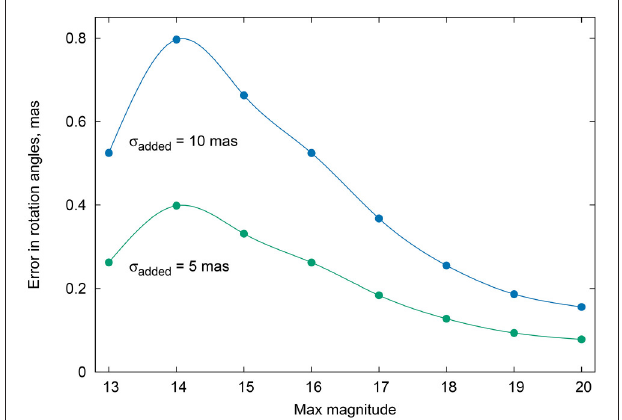
FIGURE 8 | Simulated error in orientation angles depending on the additive error due to radio–optics position shift.